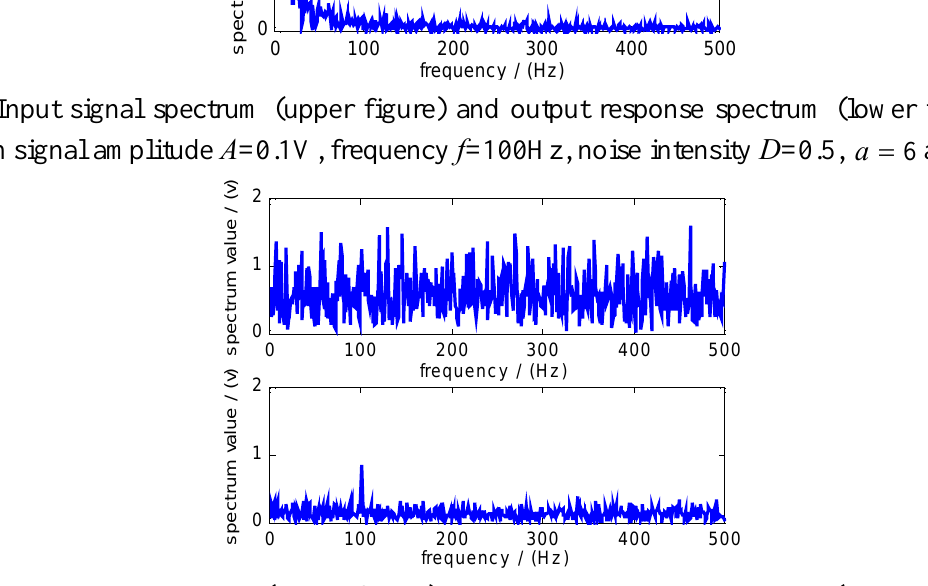
Figure 2. Input signal spectrum (upper figure) and output response spectrum (lower figure) of SR system when signal amplitude A=0.1V, frequency f =100Hz, noise intensity D